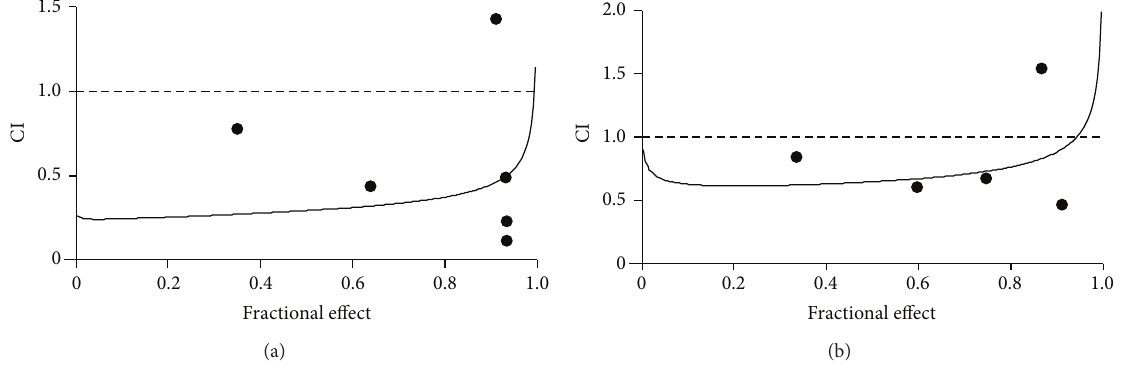
Figure 2: CI/fractional effect curves show CIs versus the fraction of cells affected by simultaneous drugs combination treatment as calculated by median drug effect analysis using CalcuSyn software in Huh7 (a) and HepG2 (b) cells. CI values (black dots) are always below 1 indicating a strong synergistic effect. The points above the CI = 1.0 line represent the maximum drugs concentration used to extrapolate the data using CalcuSyn